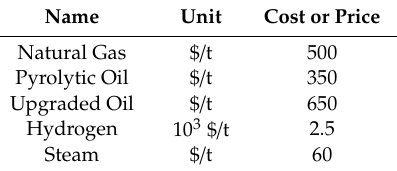
Table A2. Prices for oil and gases.